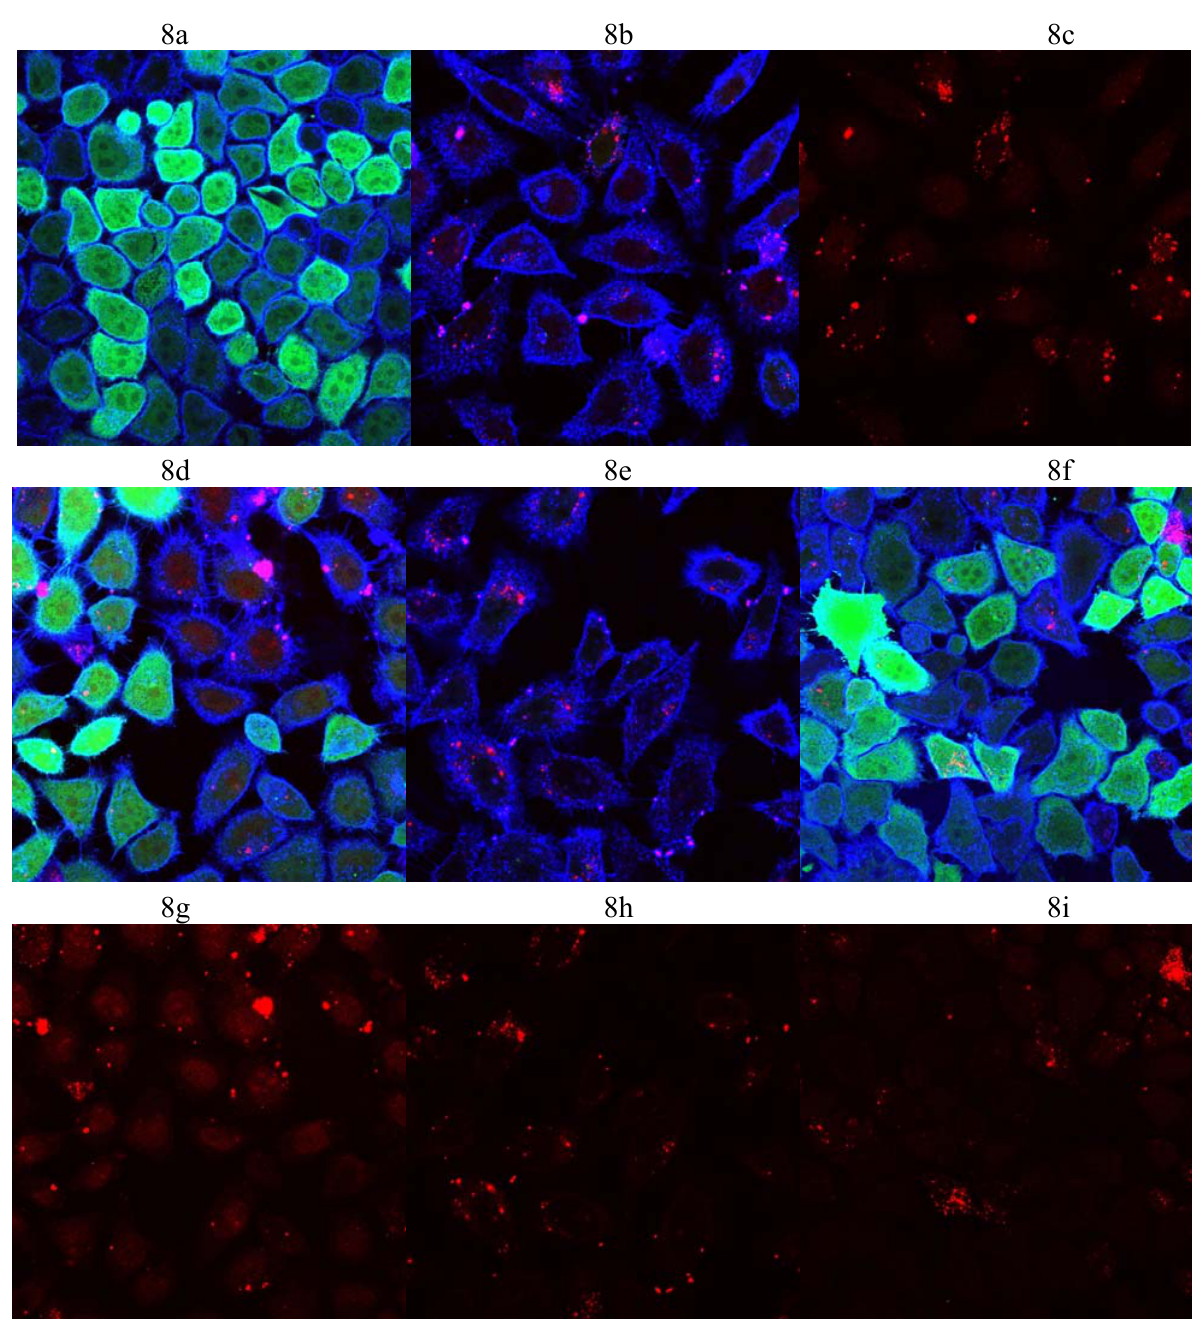
Figure 8. Confocal microscopy cell imaging. GFP fluorescence (green), cell membrane stained with WGA-Alexa Fluor® 555 (blue), and Alexa Fluor® 647 (red) represents tagged siRNA delivery. ( a ) non-transfected HeLa cells (control); ( b ) reduction in GFP expression after transfection with siRNA against GFP delivered with 3 (6 µg/well); ( c ) as b, but only the red channel; ( d ): as b, but using scrambled siRNA; ( e ) reduction in GFP expression after transfection with siRNA against GFP delivered with 4 (6 µg/well); ( f ) as e, but using scrambled siRNA; ( g ): as d, but only the red channel; ( h ) as e, but only the red channel; ( i ) as f, but only the red